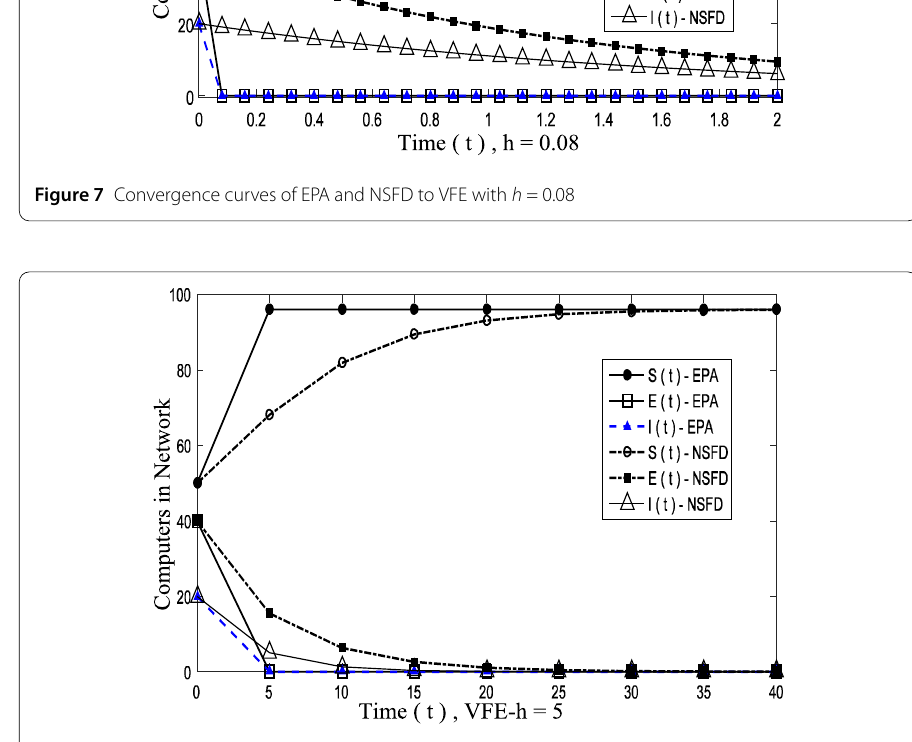
Figure 8 Convergence curves of EPA and NSFD to VFE point at h =